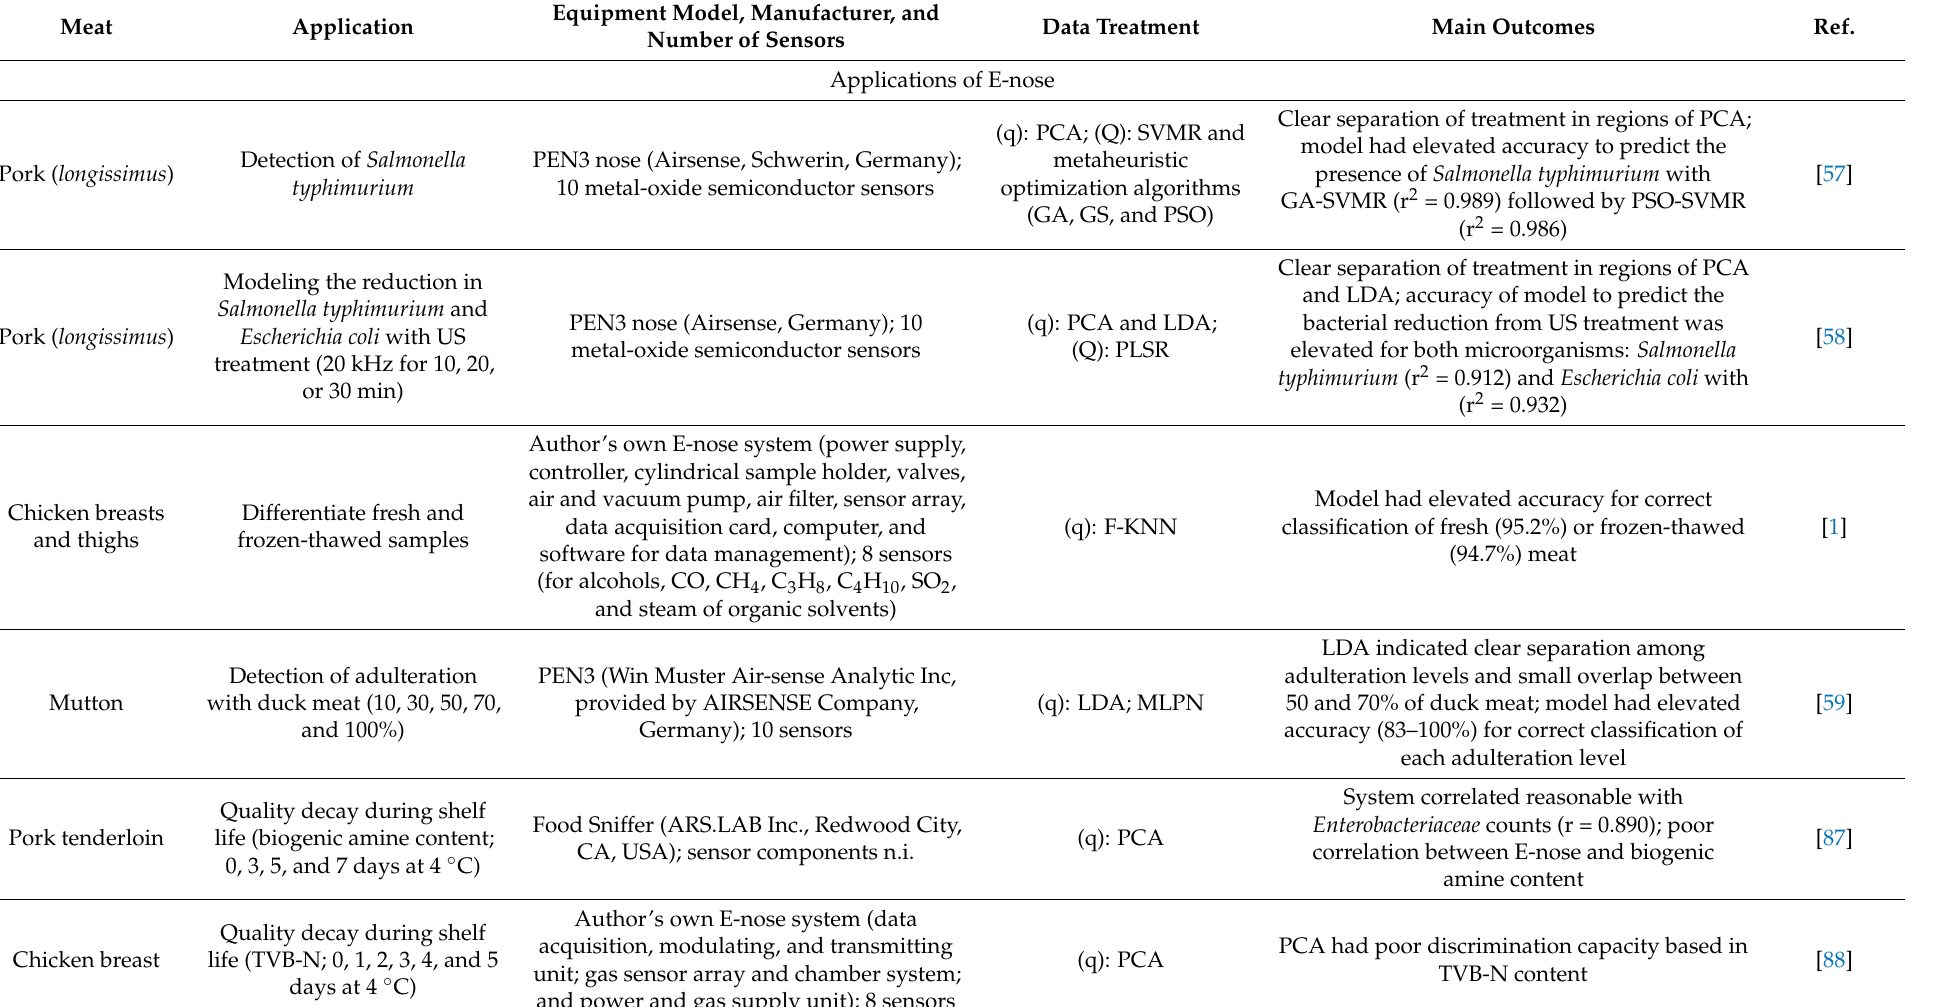
Table 1. Application of E-nose, E-eye, and E-tongue in fresh